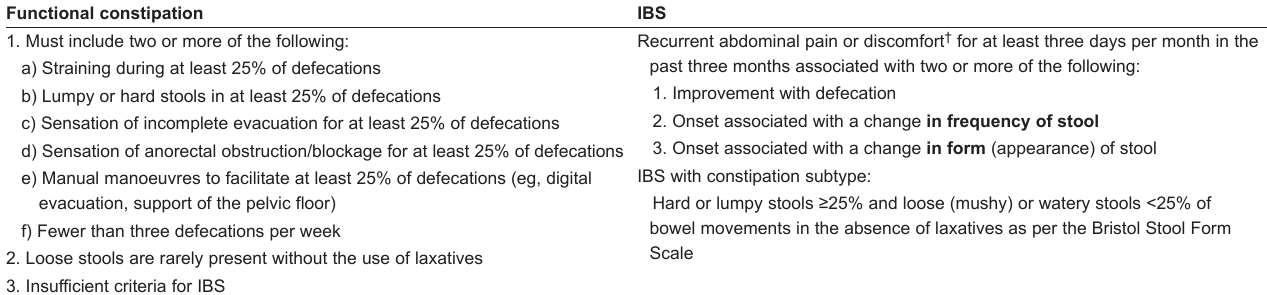
Table 1 The Rome III diagnostic criteria* for functional constipation and irritable bowel syndrome (IbS) (4) Functional